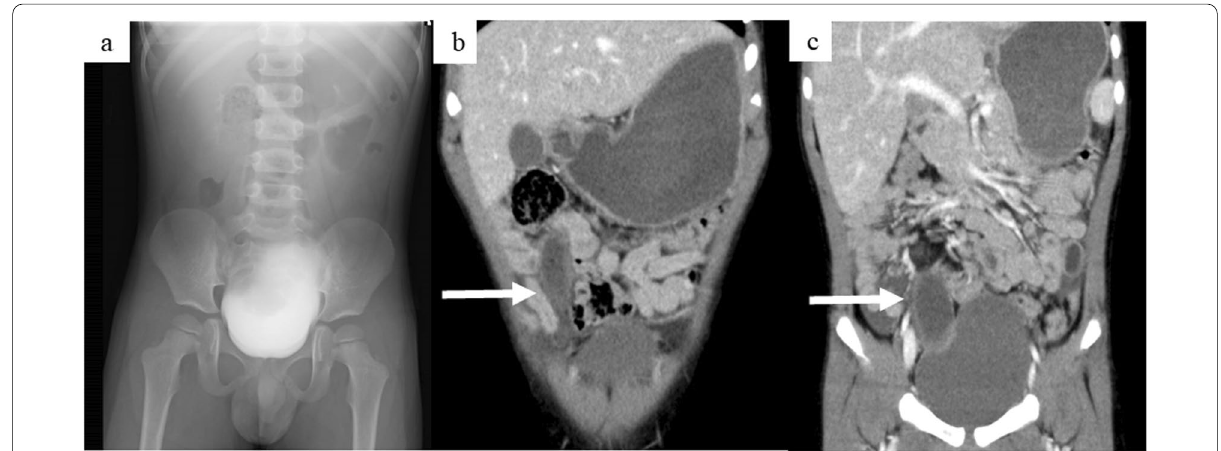
Fig. 1 Abdominal X-ray and contrast-enhanced CT. a An abdominal X-ray did not show dilation of intestine and findings of ileus. b , c From the right middle abdomen to the bottom of the pelvis, we detected a gastrointestinal-like lesion (arrow) that was blind with fluid retention